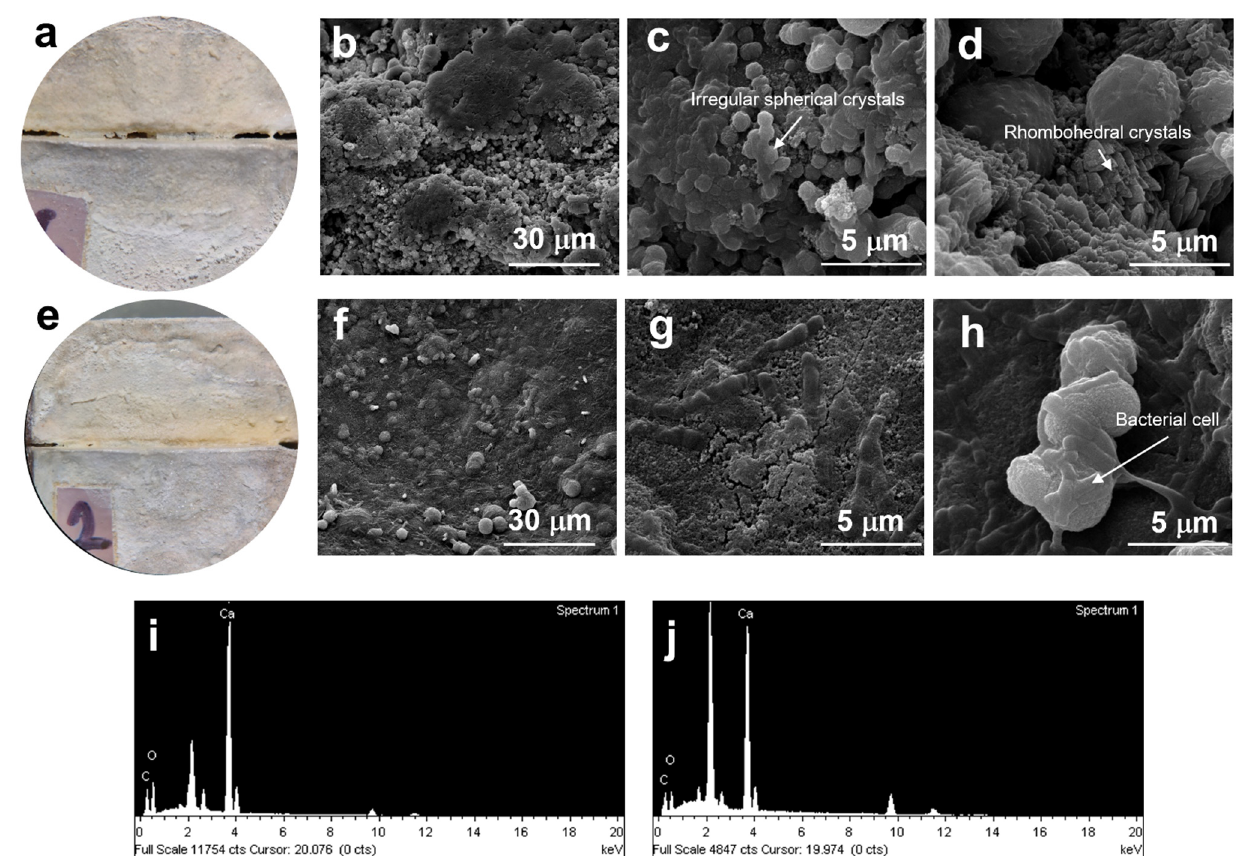
Figure 7. Microscopy images of the filled-cracks, SEM images and EDS spectra of CaCO 3 particles in the mortar specimens induced by L. fusiformis 5.1 ( a – d , i ) and L. xylanilyticus 4.3 ( e – h , j ).